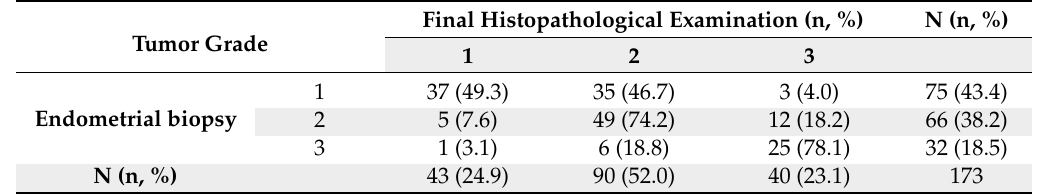
Table 4. Concordance between endometrial biopsy and final histopathological examination on tumor grade. Final Histopathological Examination (n, %) N (n, %) Tumor Grade 1